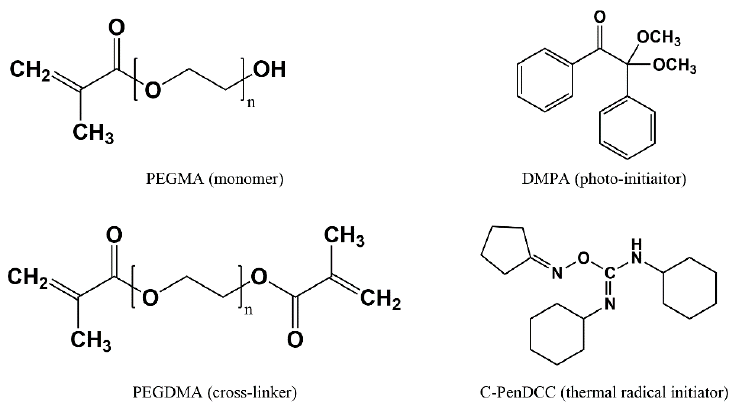
Figure 1. Chemical structures of poly(ethylene glycol) methacrylate (PEGMA), poly(ethylene glycol) dimethacrylate (PEGDMA), 2,2-dimethoxy-2-phenylacetophenone (DMPA), and cyclopentane- N , N (cid:48) - dicyclohexylcarbo diimide (C-PenDCC). Table 1. Formulation of several pre-polymerized mixtures for UV and thermal polymerizations. Polymers